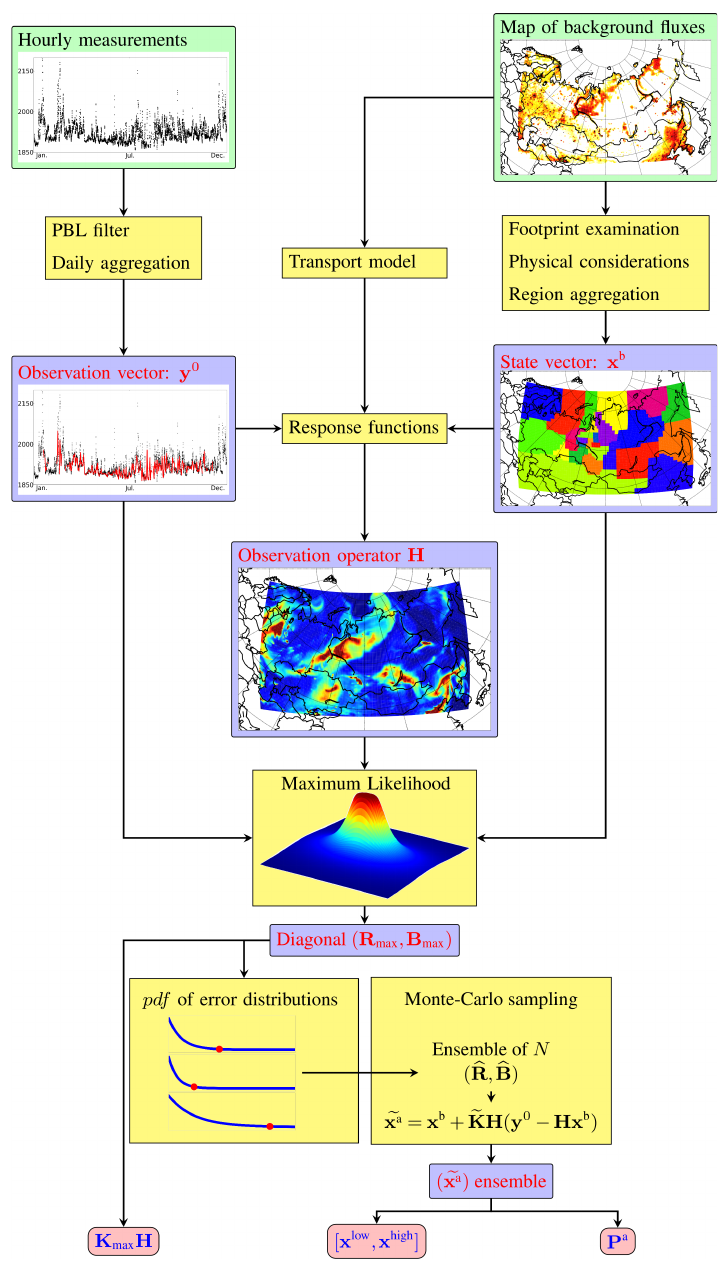
Figure 2. Block diagram of the method. Green boxes represent the raw inputs of the system. The blue ones are intermediary results and red ones the outputs to be interpreted. The yellow ones depict the algorithms to compute. Details in Sects. 2 and 3. Insights for output analyses are given in Sect.